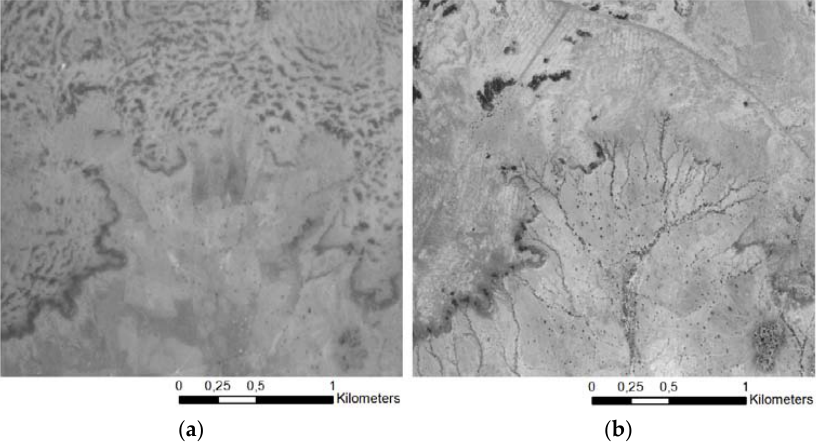
Figure 13. Original images of Kirib Kaina utilised to test the method. ( a ) Image IGN, 3/1975; ( b ) Image Digital Globe, January 2010.